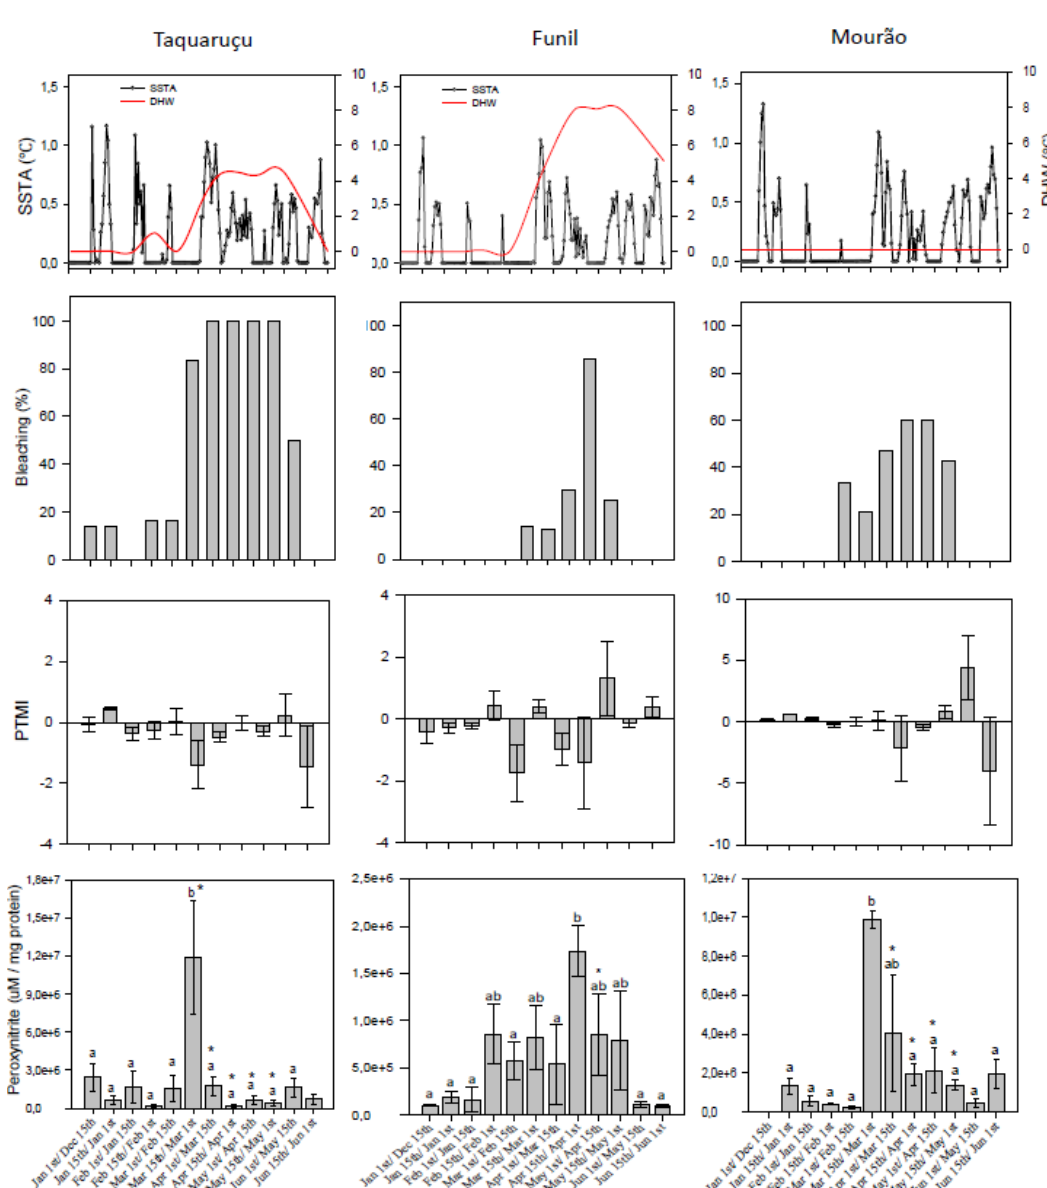
Figure 2. Thermal stress parameters [degree heating weeks (DHW) and daily sea surface temperature anomaly (SSTA)], bleaching frequency (%), Predominant Trophic Mode Index (PTMI), and peroxynitrite levels (µM/mg protein) for Millepora alcicornis at the three sites (Taquaruçu, Funil, and Mourão) of the Recife de Fora Marine Protected Area (Southwestern Atlantic), from January 2015 to June 2016, during El Niño Southern Oscillation. For peroxynitrite, different letters indicate significant differences over time ( p ≤ 0.05), and asterisks (*) indicate more than 40% bleaching frequency observed. Data on PTMI and peroxynitrite are means ± s.e.m of three to four samples.